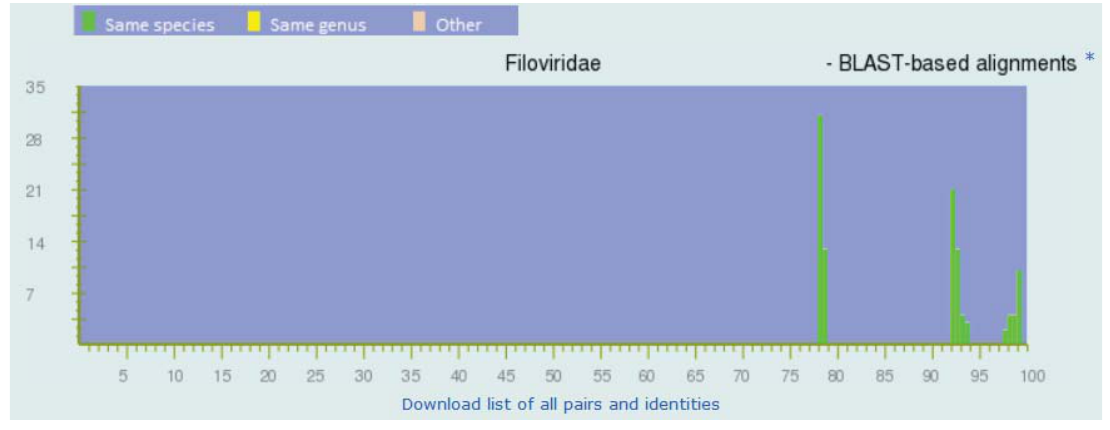
Figure 1. The accession numbers of two filovirus genomes, DQ447657 (Marburg virus — Angola2005 isolate Ang0214) and JQ352763 (Ebola virus isolate Mayinga), were entered into the “Sequence” box of the PASC page for the Filoviridae family, and compared with existing filovirus genomes and with each